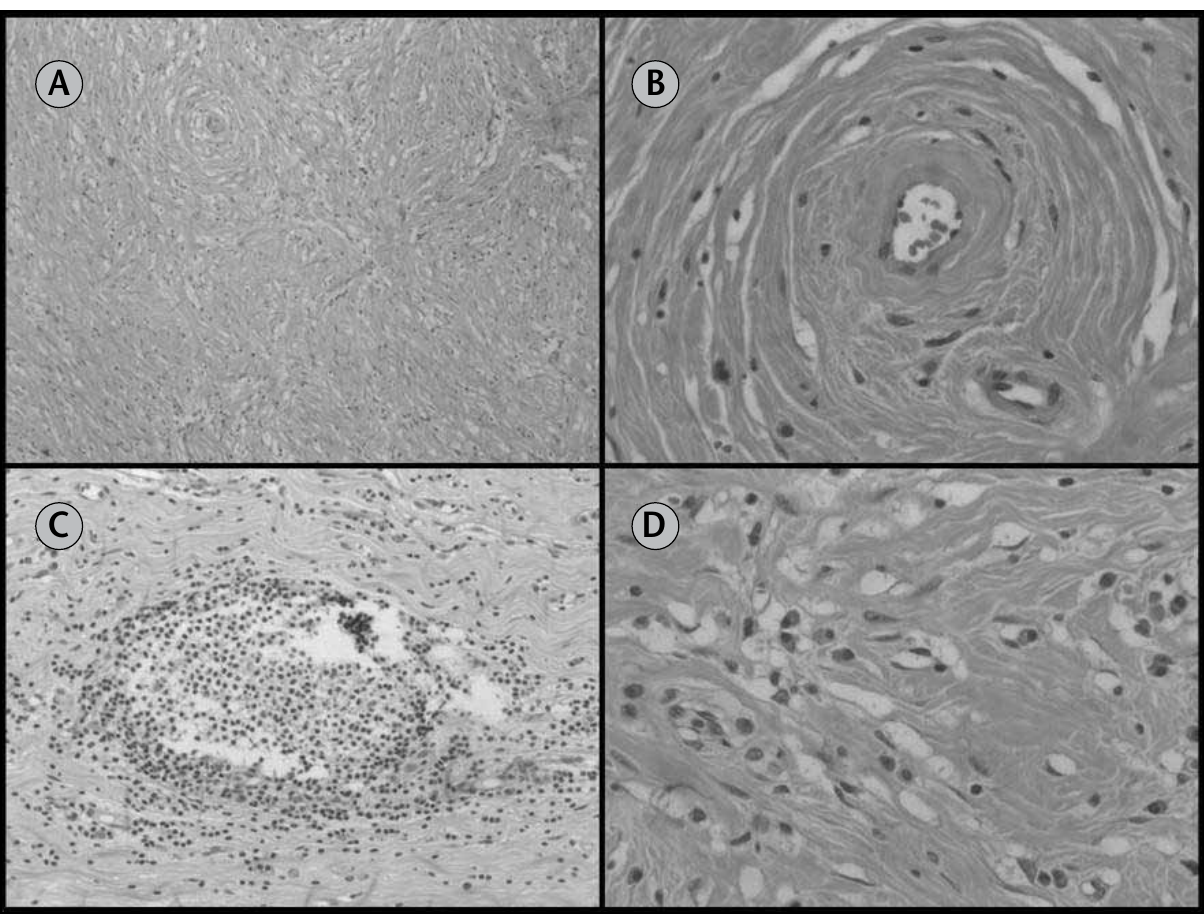
Figura 2 – (A) Fotomicrografia mostrando denso estroma colanenoso; (B) proliferação miofibroblástica perivascular com redução do lúmen; (C e D) denso infiltrado